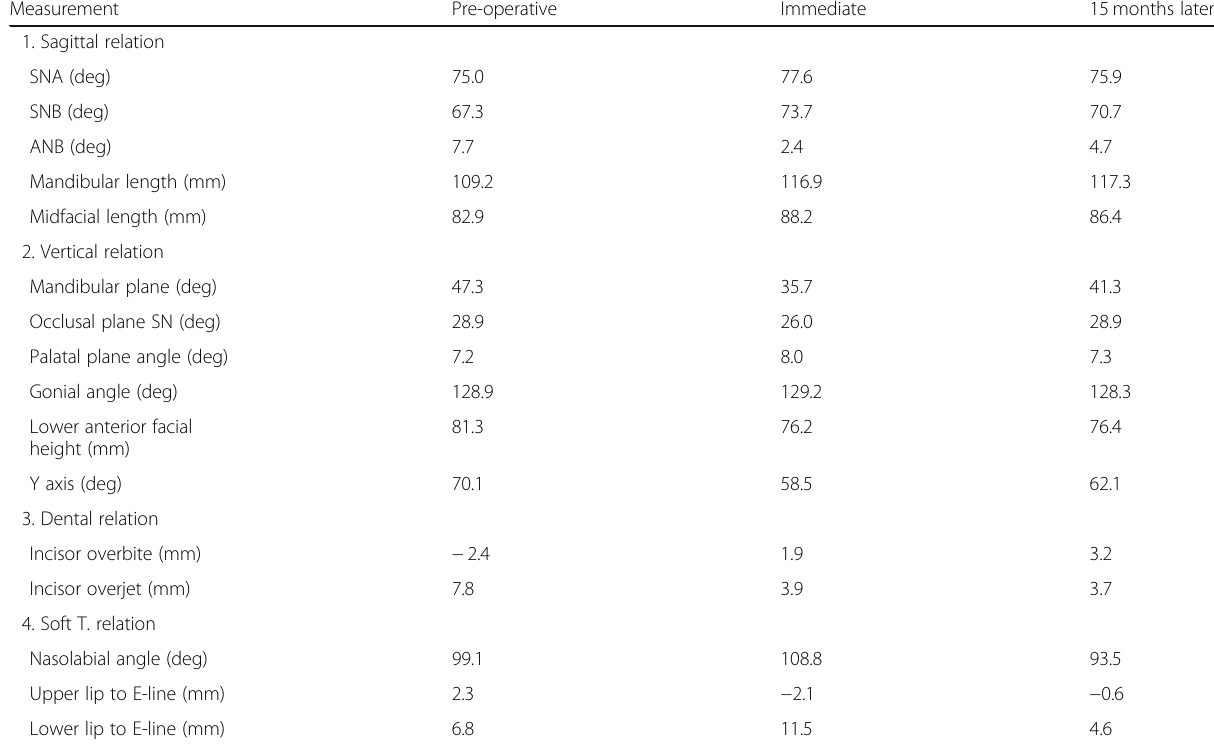
Table 1 Summary of the patient ’ s cephalometric measurements Measurement Pre-operative Immediate